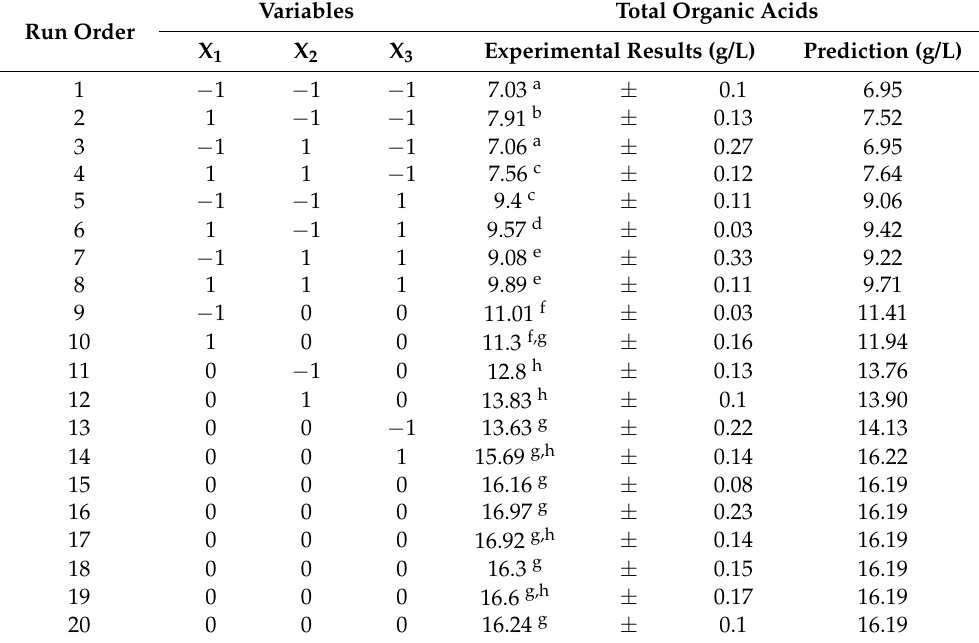
Table 2. Experimental design (CCD) and results of total organic acids production by the mixed anaerobic culture at 48 h of fermentation [Data are shown as mean ± standard deviation of three replications. Means with different superscript letters are different by Tukey’s test ( p <